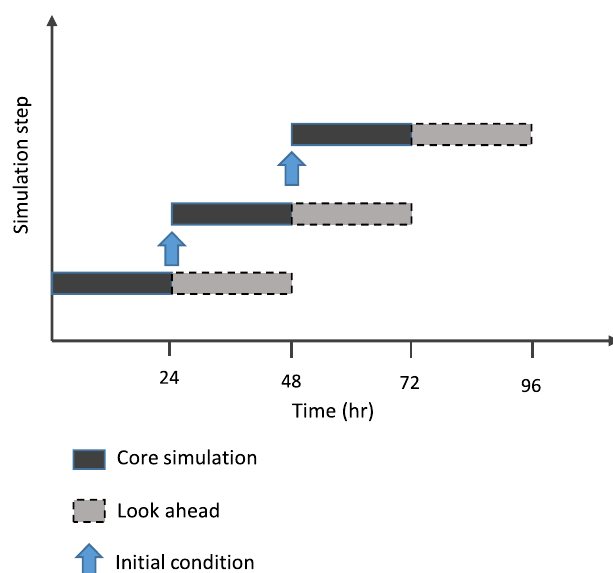
Figure 7. Temporal structure of the day-ahead simulation.